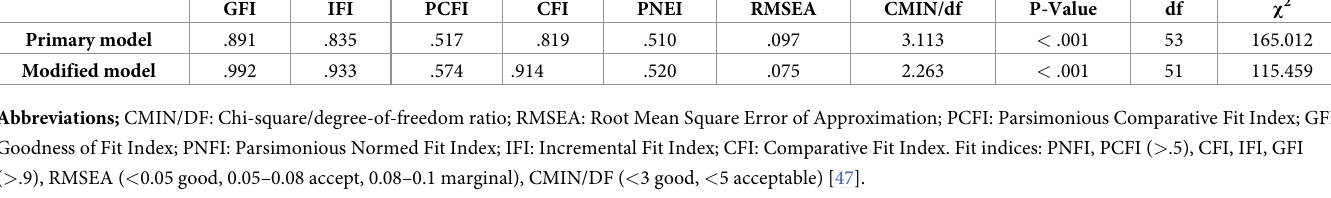
in this model. Fig 1 shows the standard coefficients of the research model. The standardized regression coefficient showed that PA had a significant and inverse rela- tionship with BMI (P < 0.001, β = -0.671) and a significant and direct relationship with QOL (P < 0.001, β = 0.501). In addition to these relations, BMI has also proven to be inversely related to QOL (P < 0.001, β = -0.396). Bootstrap testing showed BMI has a mediatory role in the relationship between PA and QOL (P < 0.001, Indirect Effects = 0.265) (Table 4). Path coefficients of the research model with respect to gender have been presented in Table 5. The fitting indices validate the proposed pattern in both genders, as shown in Table 5. It can be perceived that the effect of BMI on QOL was significant in men (P < 0.001, β = -0.307) in compare to women (P = 0.324, β = -0.158). The other paths however exhibit no dif- ference between the two genders. The measured weight model (in two models unconstrained and constrained) results signify gender as a moderator in the relationship between physical activity and QOL ( Δχ 2 (10) = 19.903, P = 0.030) and also the mediatory role of BMI among stu- dents. In the modified model, by drawing a correlation between the errors (e1-e2 and e2-e4) the fit indices was improved (Fig 2). The results also showed that the indirect effect of BMI on physical activity and quality of life in men ( β = 0.203, P < .001) was higher and more significant than in women ( β = 0.104, P < .001). Other independent variables were not included in the model.